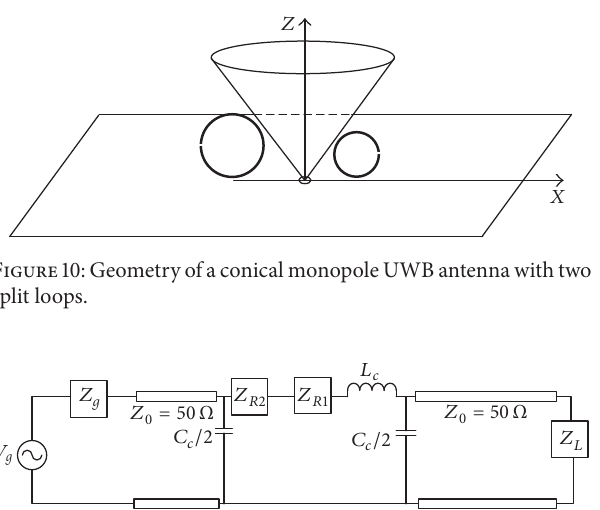
Figure 11: Equivalent circuit of two bands suppressed conical monopole UWB antenna.